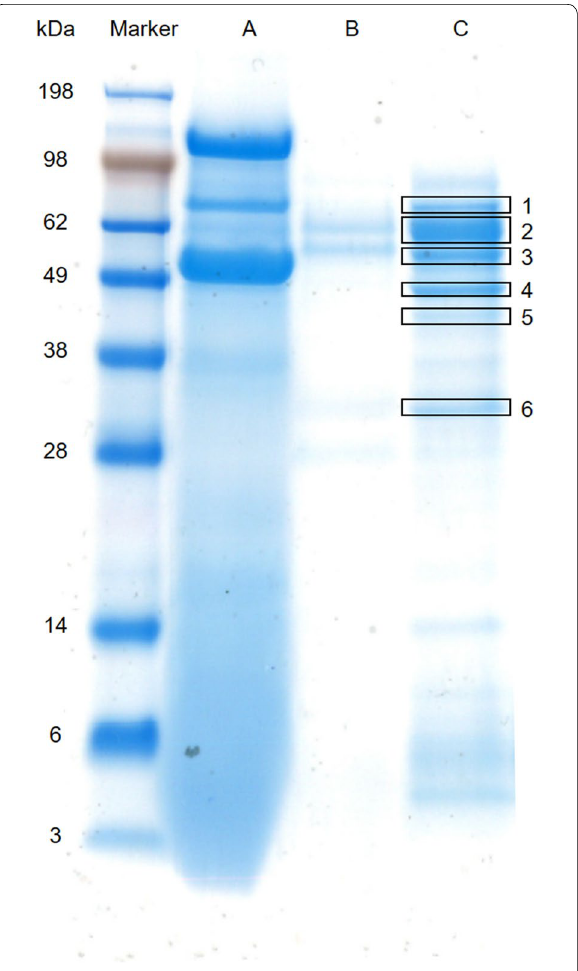
Fig. 6 SDS-PAGE analysis of the produced TMEs. SDS-PAGE analysis of the produced tailor-made enzymes (TMEs). Lane Marker) SeeBlue plus 2 pre-stained marker Lane A) YPD medium after Schwanniomyces occidentalis growth Lane B) Trichoderma harzianum medium before S. occidentalis addition Lane C) T. harzianum medium at the end of the cultivation. In lane C, the six bands that are boxed were